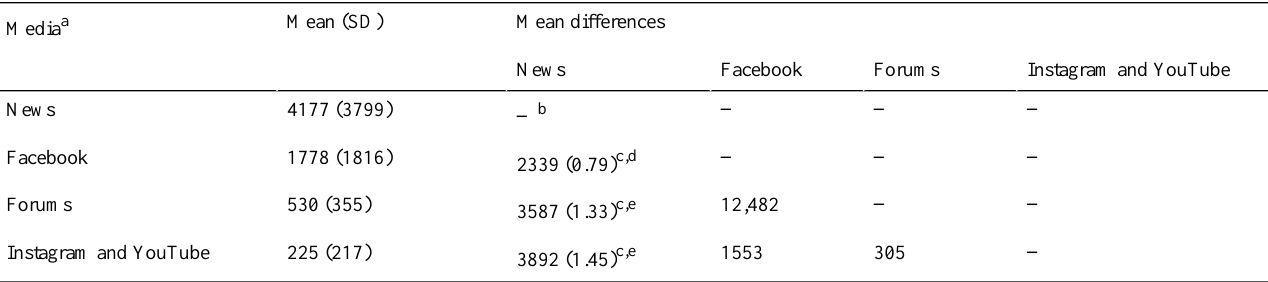
Table 4. Differences between media venue with sentiment on targets according to post hoc